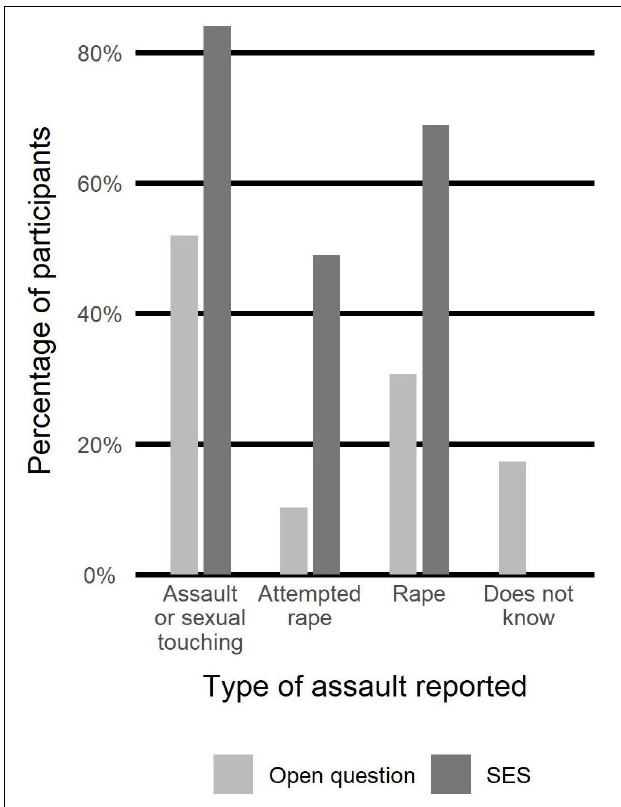
FIGURE 5 | Comparison of assaults reported by participants through the two questionnaires.